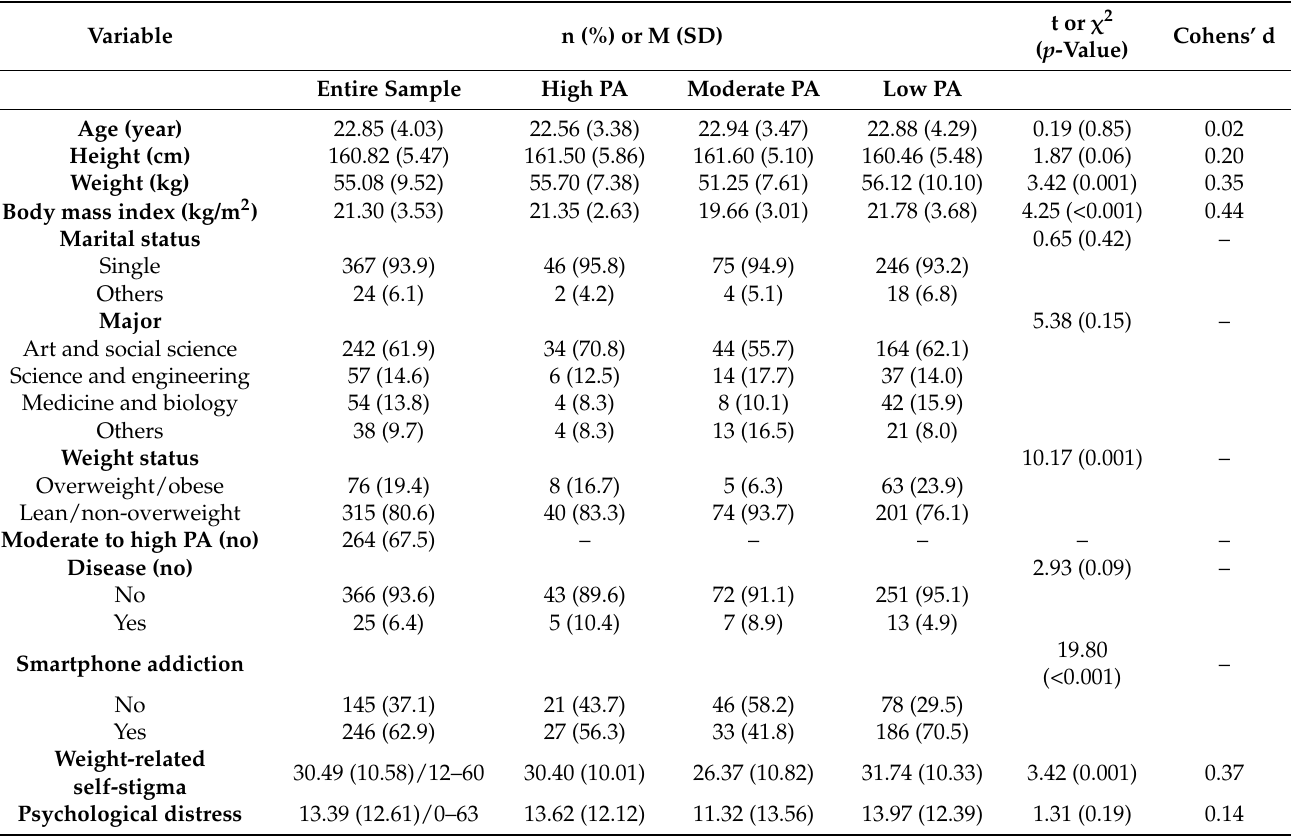
Table 1. Participants’ characteristics for the entirety (N = 391), and those with high (n = 48), moderate (n = 79), and low (n = 264) physical activity (PA).